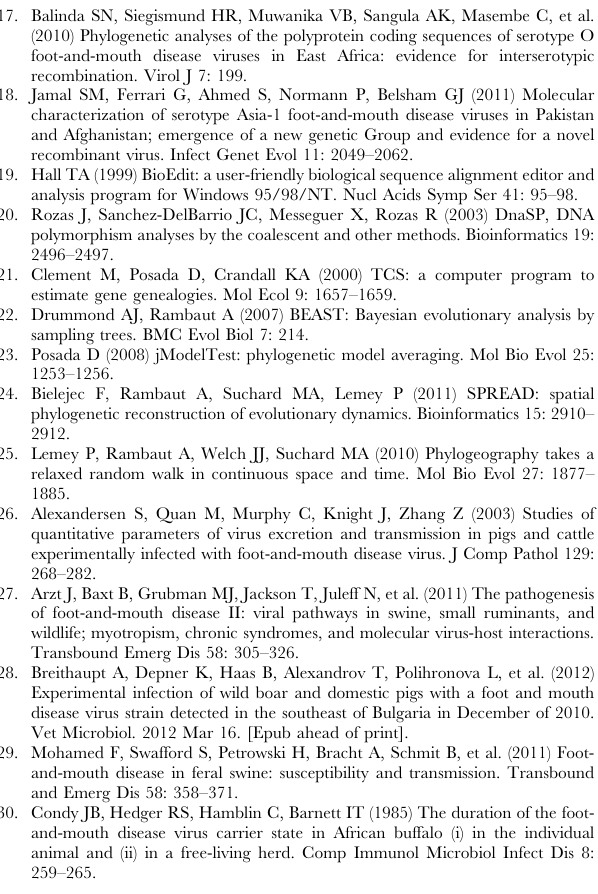
Table S2 Oligonucleotide primers used for the FMDV amplification and sequencing at the National Veterinary Institute (Denmark). (DOCX) Video S1 Spatiotemporal reconstruction of the incur- sion of FMDV into Bulgaria from Anatolia (Turkey). (MP4) Video S2 Spatiotemporal reconstruction of the incur- sion of FMDV within Burgas region (Bulgaria).